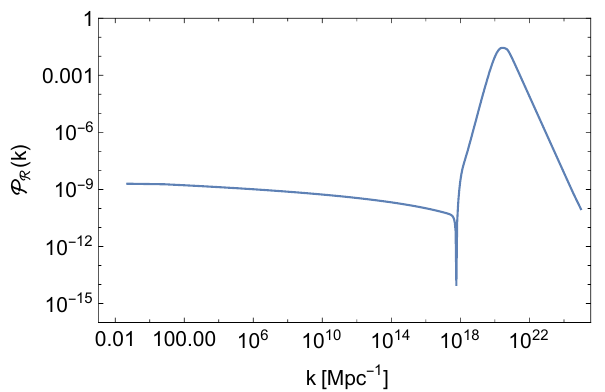
Figure 8. The power spectrum of the comoving curvature perturbations for the model (86) and potential depicted in Figure 7. The power spectrum has a peak at large wavenumbers triggering the production of mini PBHs during kination